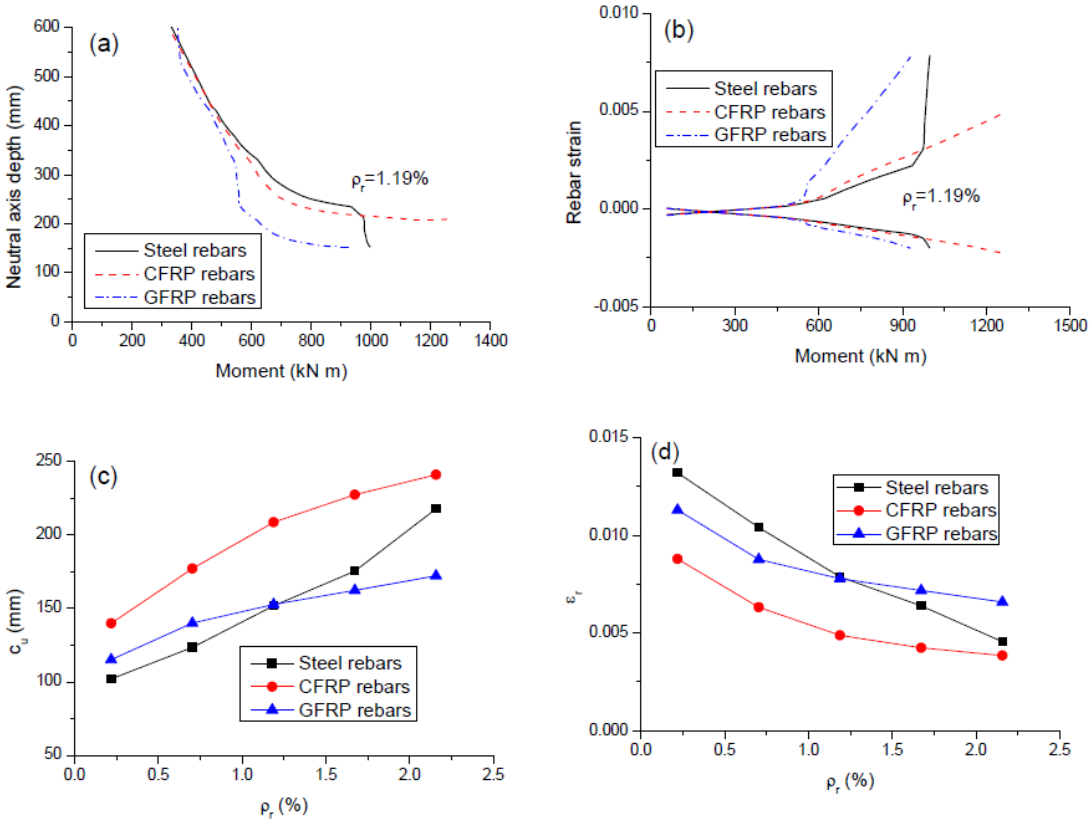
Figure 9. Neutral axis depth and bar strain for different types of rebars. ( a ) moment versus neutral axis depth at midspan; ( b ) moment versus rebar strain at midspan; ( c ) variation of ultimate neutral axis depth with varying ρ r ; ( d ) variation of ultimate tensile rebar strain with varying ρ r.